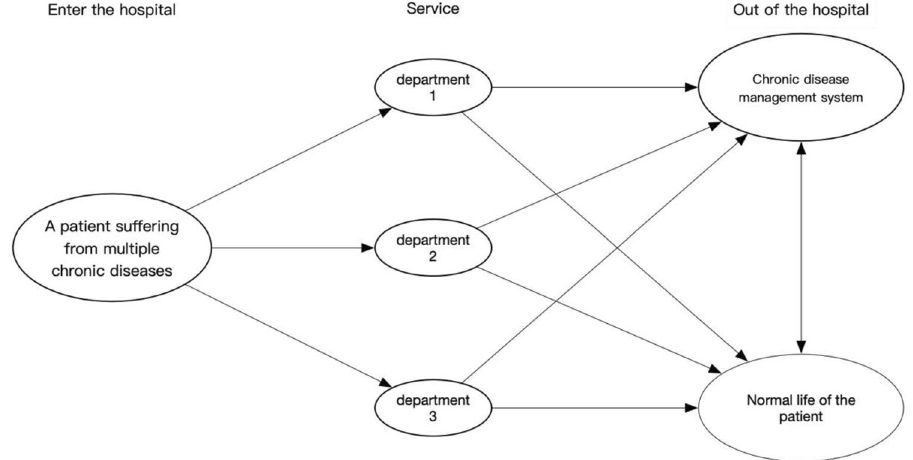
Figure 1. Schematic representation of chronic disease management in large hospitals. The arrows represent how patients with multiple diseases are transferred to different departments. Coordinated treatment by multiple departments: The arrows from the 3 department to the chronic disease management system indicate: after treatment, each department will input the patient’s treatment into the chronic disease management system; The arrows from the 3 department to the patient’s normal life indicate that the patient is discharged from hospital; The bidirectional arrow from chronic disease management system to patients’ normal life indicates that patients input their daily physical conditions into the system, and the system feedback corresponding services according to patients’